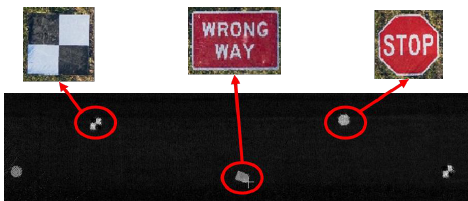
Figure 8. Intensity data from a point cloud that includes highly reflective boards highlighted by the zoomed-in